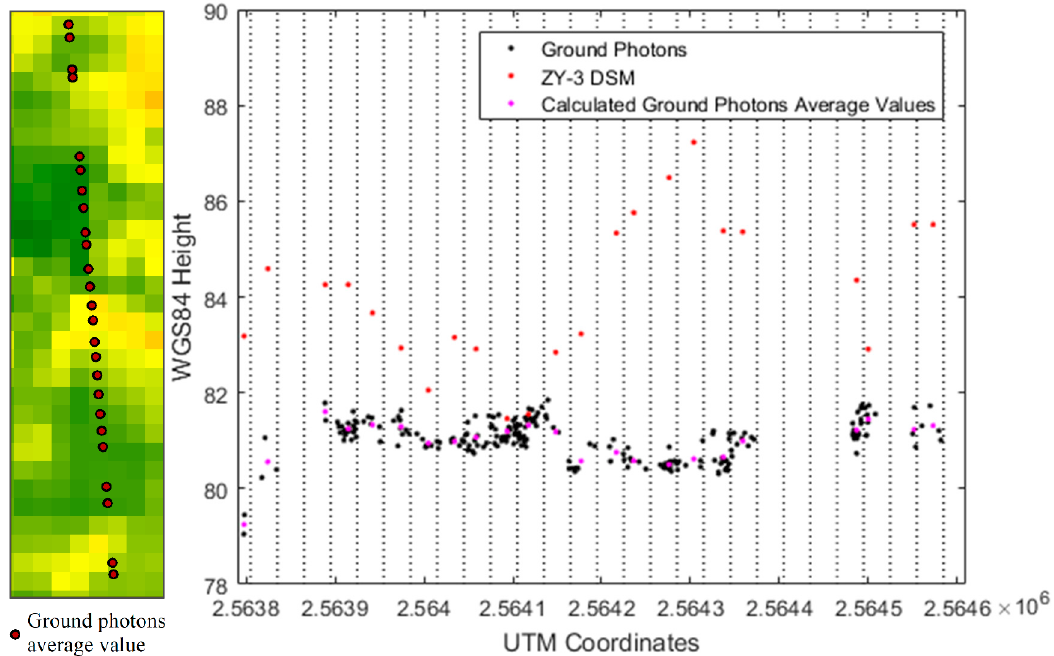
Figure 6. The vertical section profile of the discontinuous canopy height model (CHM) dataset. The interval between the dotted lines indicates a grid resolution of 30 m.